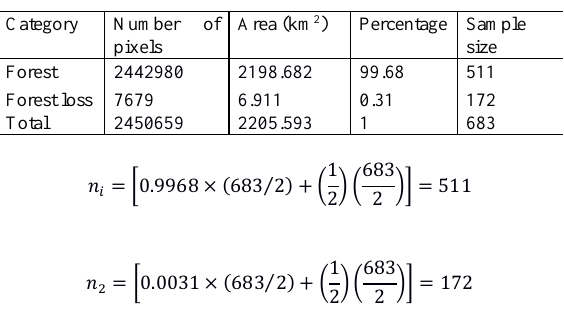
Table 1. Total detected changes and sample